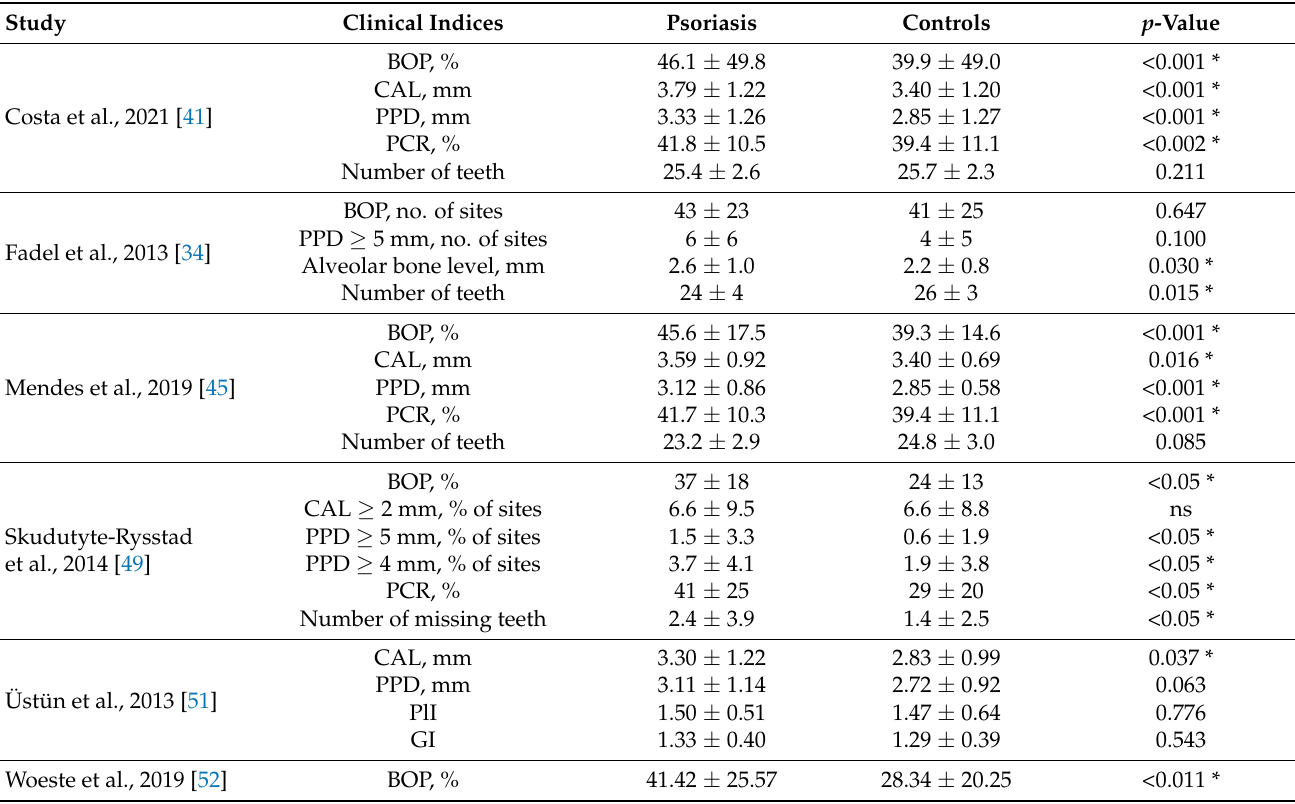
Table 3. Statistical significance for periodontal indices in patients with psoriasis.